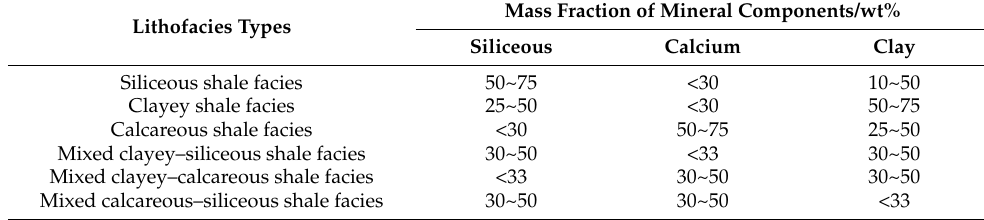
Table 4. Marine shale lithofacies division